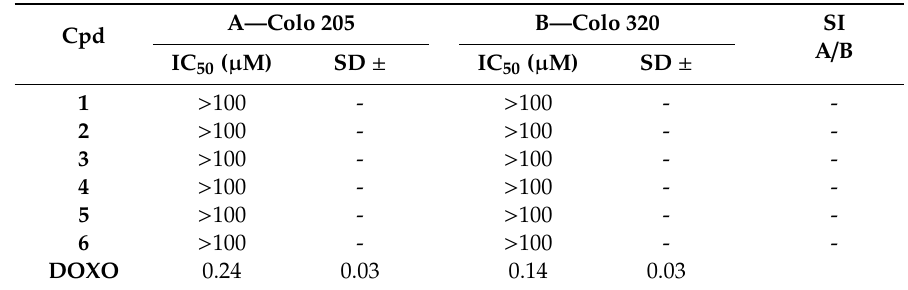
Table 2. Antiproliferative activity screening of the flavones and bioisosteric analogues. SD: standard deviation, SI: selectivity index.